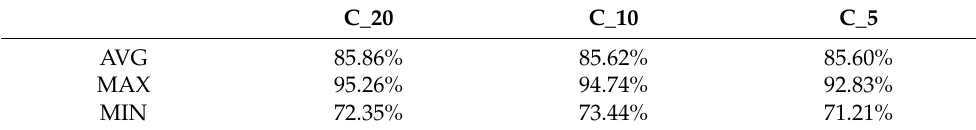
Table 3. Overall network results for DROB configurations with different sampling counters.